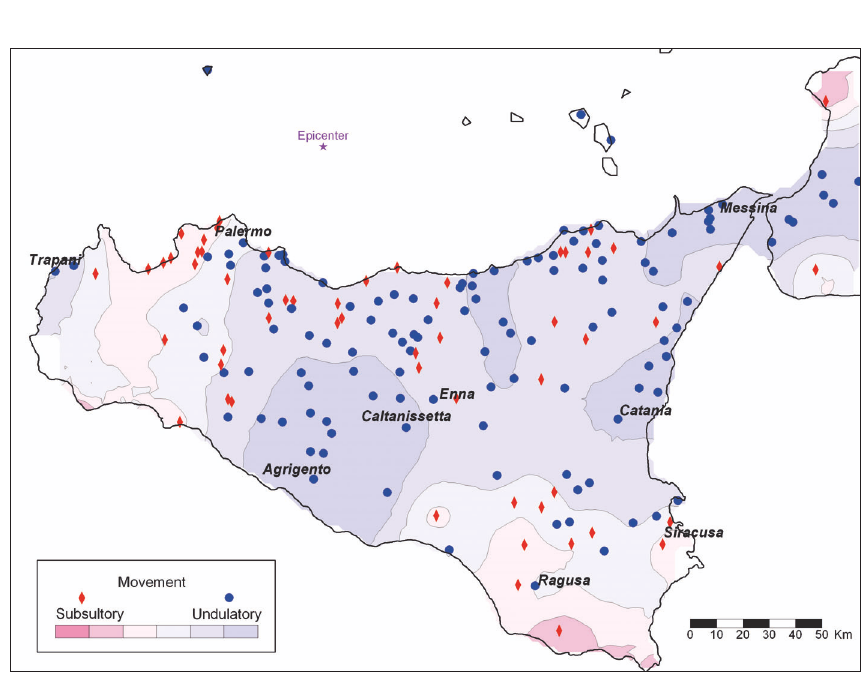
Fig. 3. Prevailing type of ground movement perceived by people during the event (subsultory or undulatory). Original data are represented with their interpolated and smoothed spatial reconstruction (color